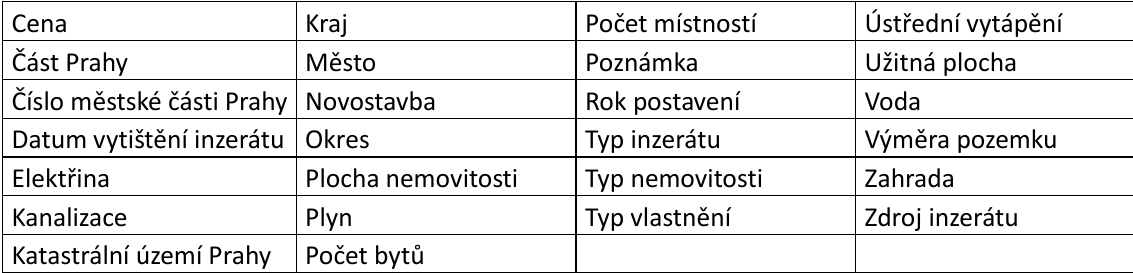
Tabulka 2: Parametry sledované v inzerátech – vlastní